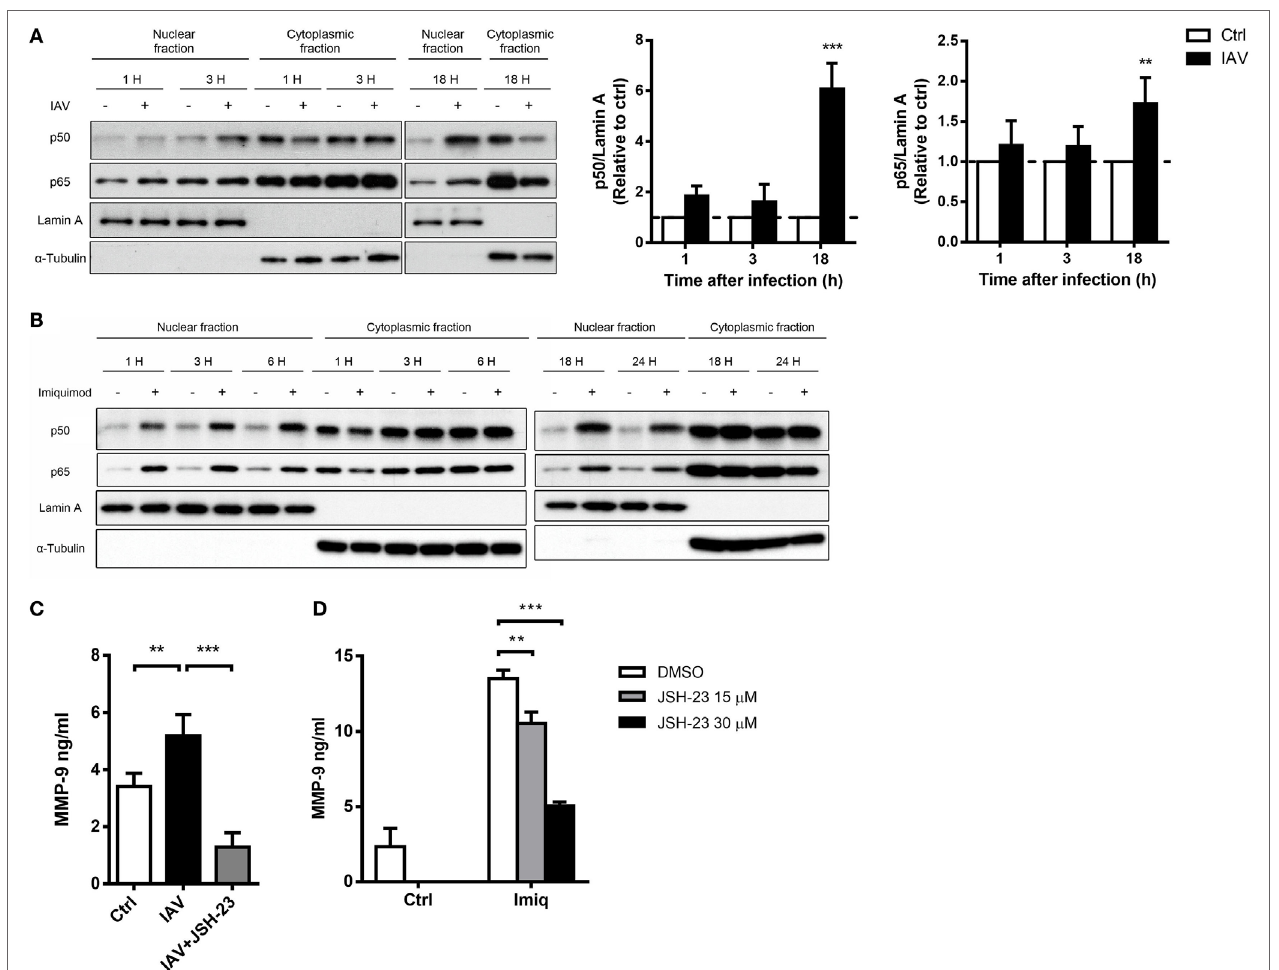
FigUre 4 | Influenza A virus and toll-like receptor 7 agonist-induced matrix metalloproteinase-9 (MMP-9) production is NF- κ B-dependent. MH-S cells were stimulated with or without (a) WSN virus (MOI = 0.25) and (B) imiquimod (Imiq, 1 µg/ml) for indicated periods of time. Cell lysates were separated into nuclear and cytoplasmic fractions and blotted with anti-p50 and anti-p65, anti-Lamin A (nuclear loading control) and anti- α -tubulin (cytoplasmic loading control) antibodies. One representative experiment is shown in (a,B) . Bar graphs in (a) show the levels of p50 and p65 protein normalized against Lamin A ( n = 3, three independent experiments). MH-S cells were stimulated with or without (c) WSN virus (MOI = 0.25) and (D) Imiq (1 µg/ml) in the presence of DMSO vehicle control or JSH-23 (NF- κ B inhibitor, 30 µM) for (c) 48 h and (D) 24 h [Panel (c) , n = 5; Panel (D) , n = 3]. MMP-9 concentration was quantified by ELISA. Data presented are the mean + SD; n.s., not significant, ** p < 0.01 and *** p < 0.001 compared to control [one-way ANOVA followed by (a) Sidak’s and (c,D) Tukey’s post hoc